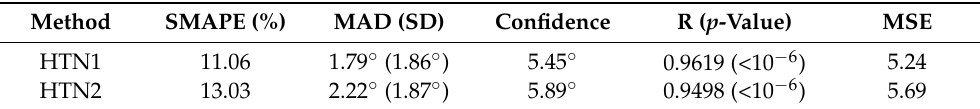
Table 2. Comparison of two network structures. HTN1 contains four residual modules (ID: 1, 2, 3, 4), while HTN2 contains three residual modules (ID: 2, 3, 4).